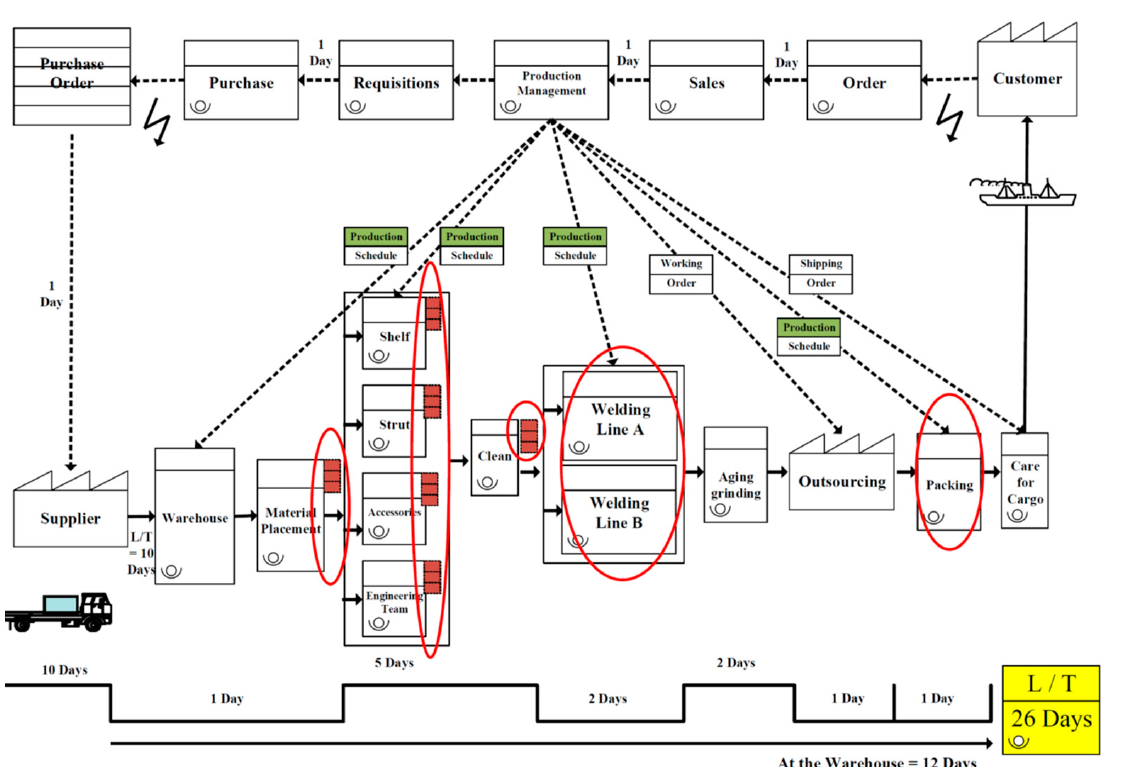
Figure 3. Production bottleneck. Table 2. VSM explosion improvement points.